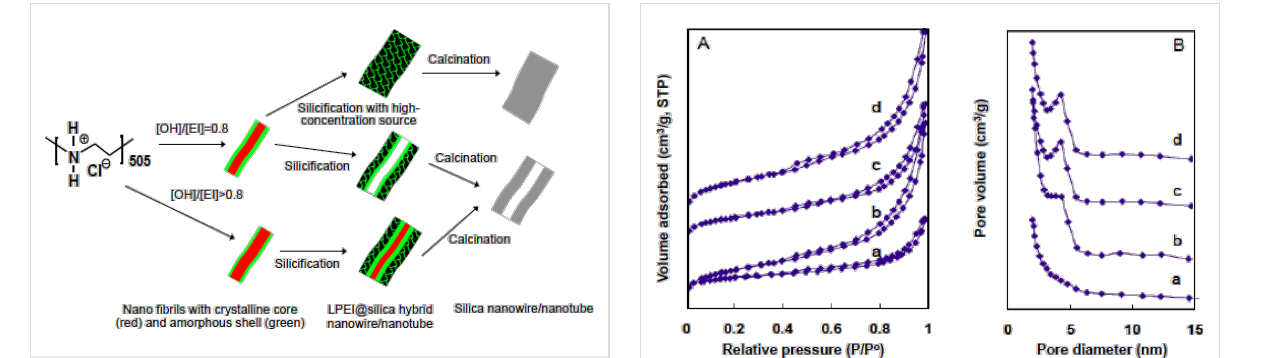
Scheme 1: Proposed formation mechanism of the polyamine-aggre- gate template for silica nanotubes and nanowires formed by the alkali- induced self-assembly of LPEI.